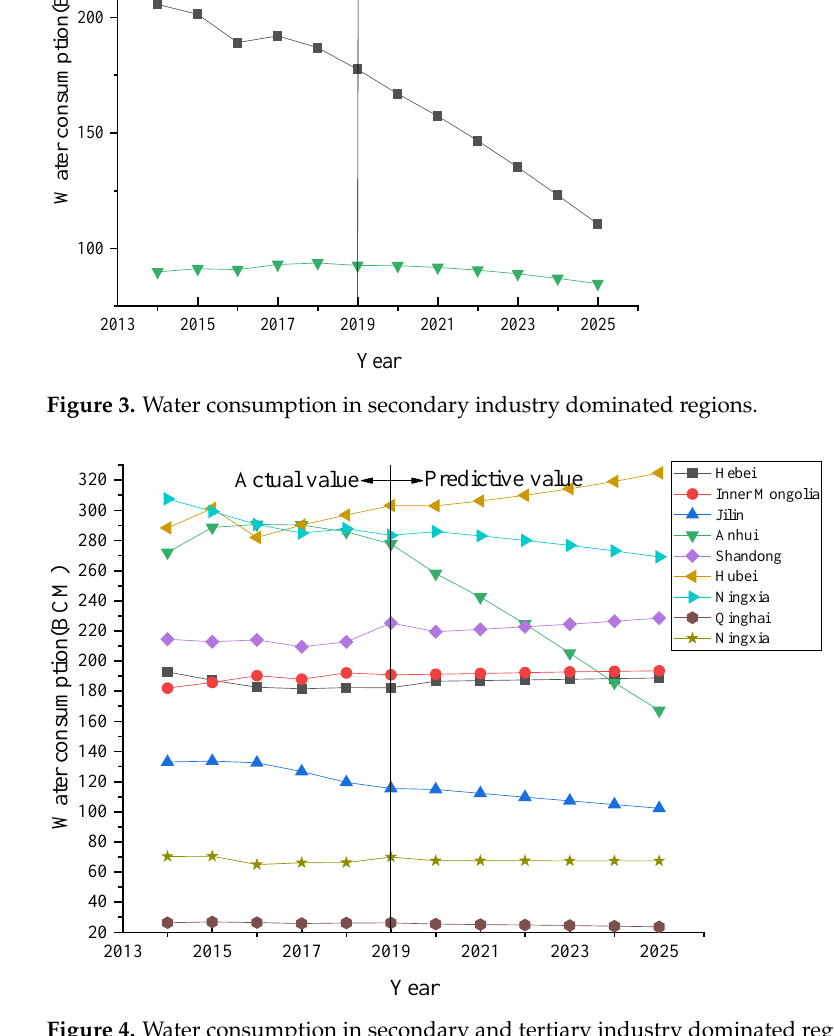
Figure 4 . Water consumption in secondary and tertiary industry dominated regions.